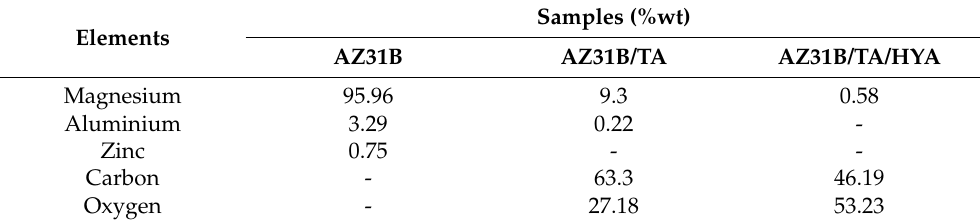
Table 3. EDS results of samples AZ31B, AZ31B/TA, and AZ31B/TA/HYA after